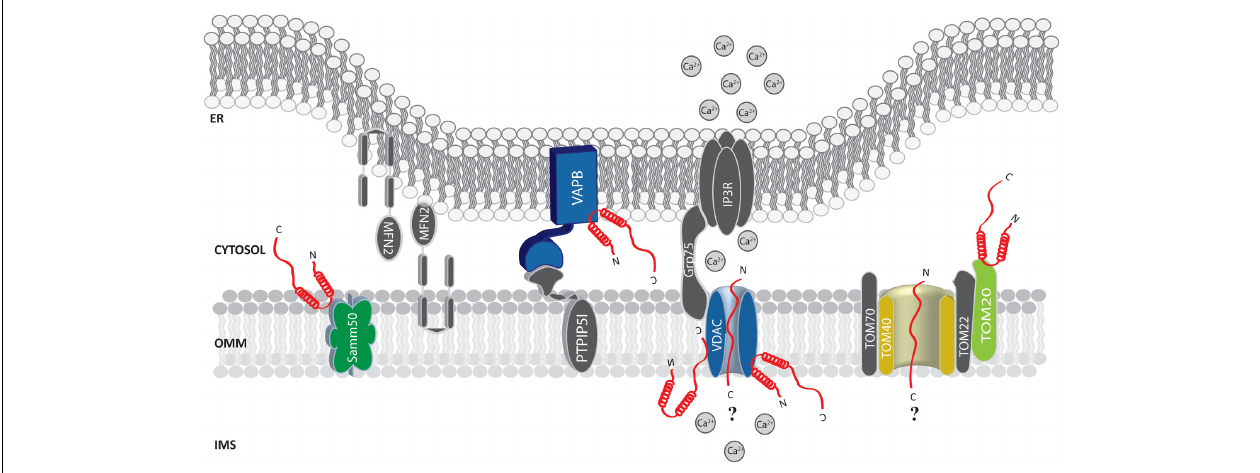
FIGURE 2 | Alpha-syn at the mitochondria-associated membranes (MAMs) and the OMM. Picture shows α -syn binding partners at the MAMs and OMM. The protein’s interactors are highlighted in colors. The possible (?) mechanism/s of α -syn translocation inside mitochondria are also reported. A-syn is shown in